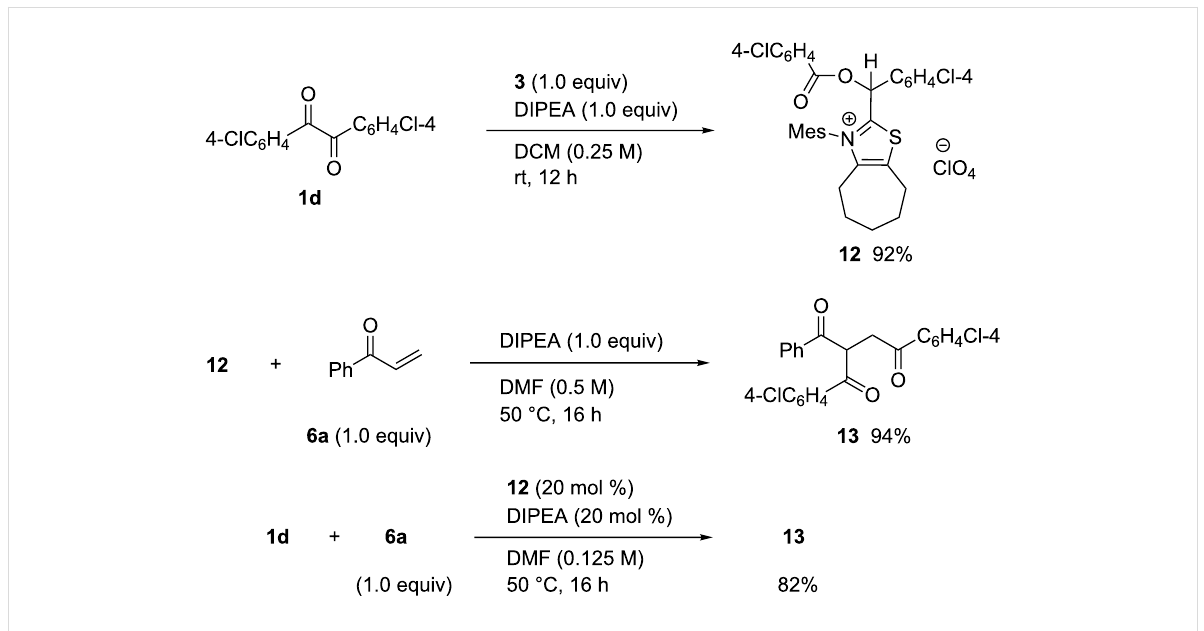
Scheme 6: Preparation of the iminium salt 12 and its reactivity.